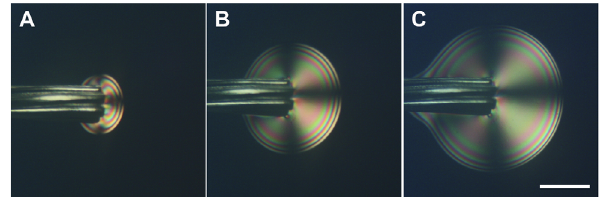
Figure 3. Optical images with crossed polarizers of a bundle of silver plated copper wires immersed in a drop of 5.5wt% CNCs in water and held at 1 V for A) 1 min, B) 5 min, C) 10 min. The position of the crossed polarizers is drawn in Figure 1 panel A. The scale